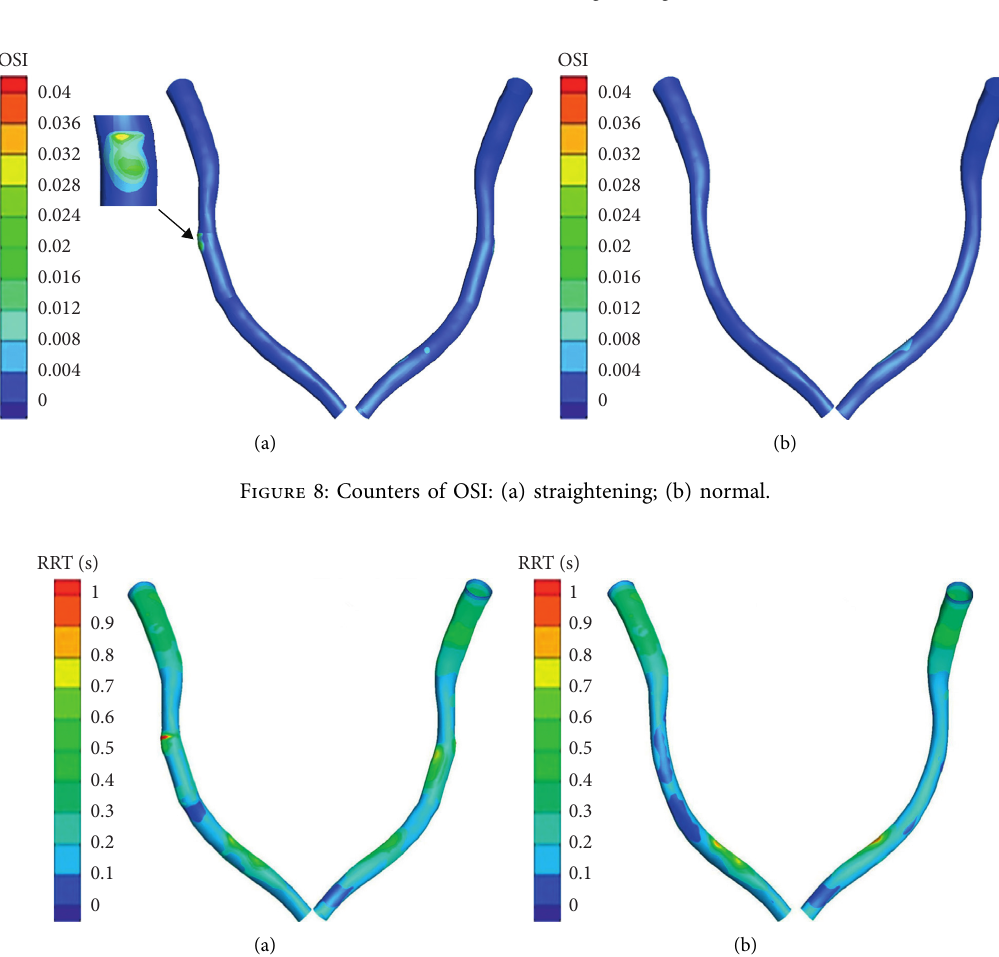
Figure 7: Counters of TAWSS: (a) straightening; (b) normal.